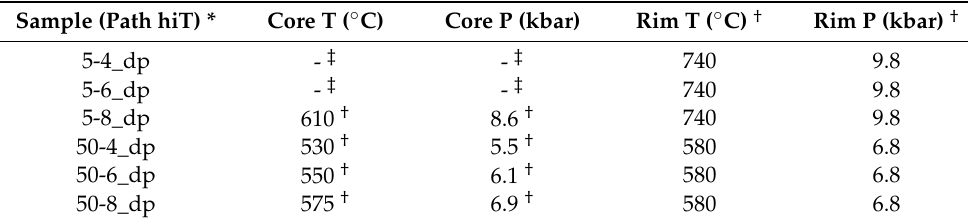
Table 3. Garnet core and rim P-T